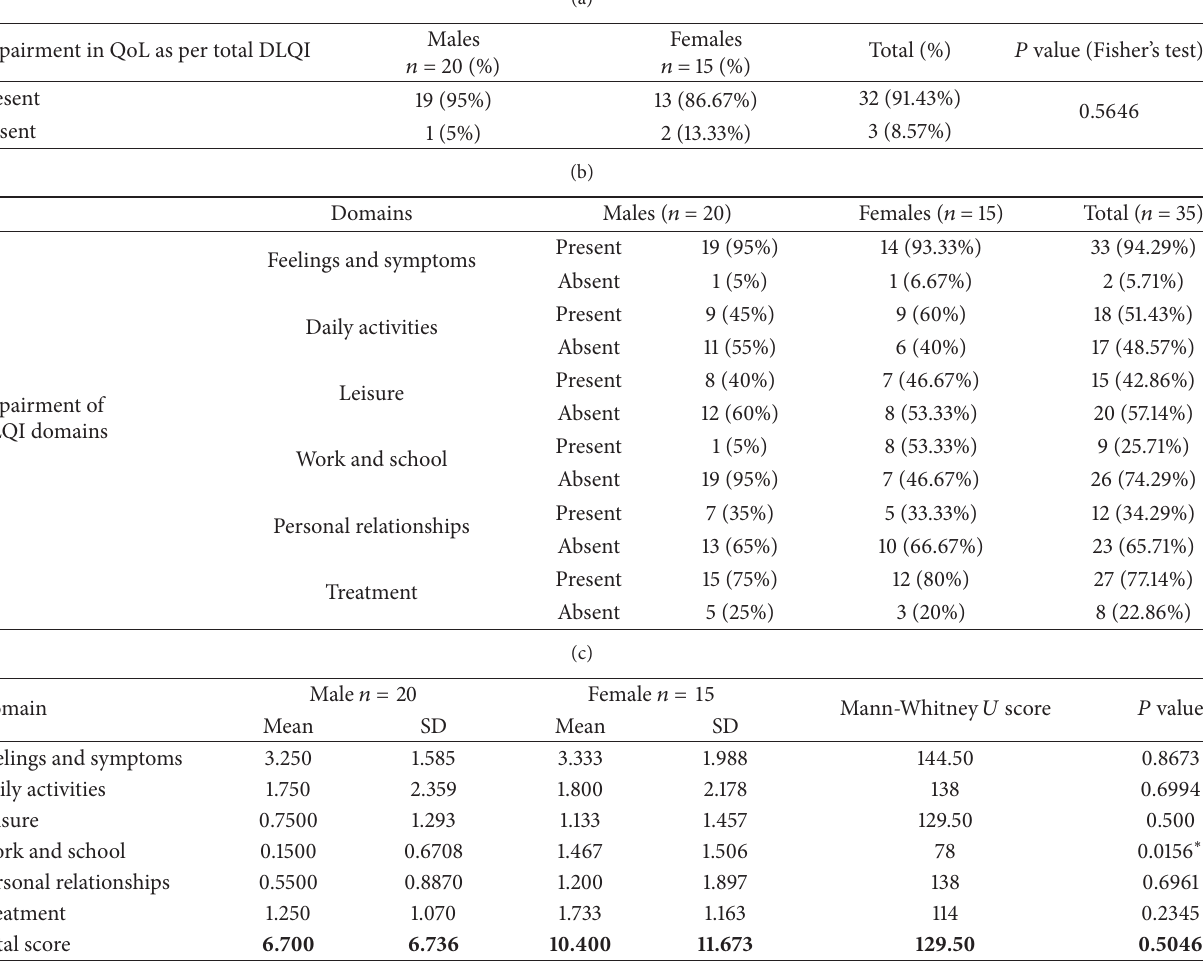
Table 3: (a) Prevalence in impairment of QoL. (b) Gender differences in DLQI domains. (c) Comparison of gender differences in DLQI